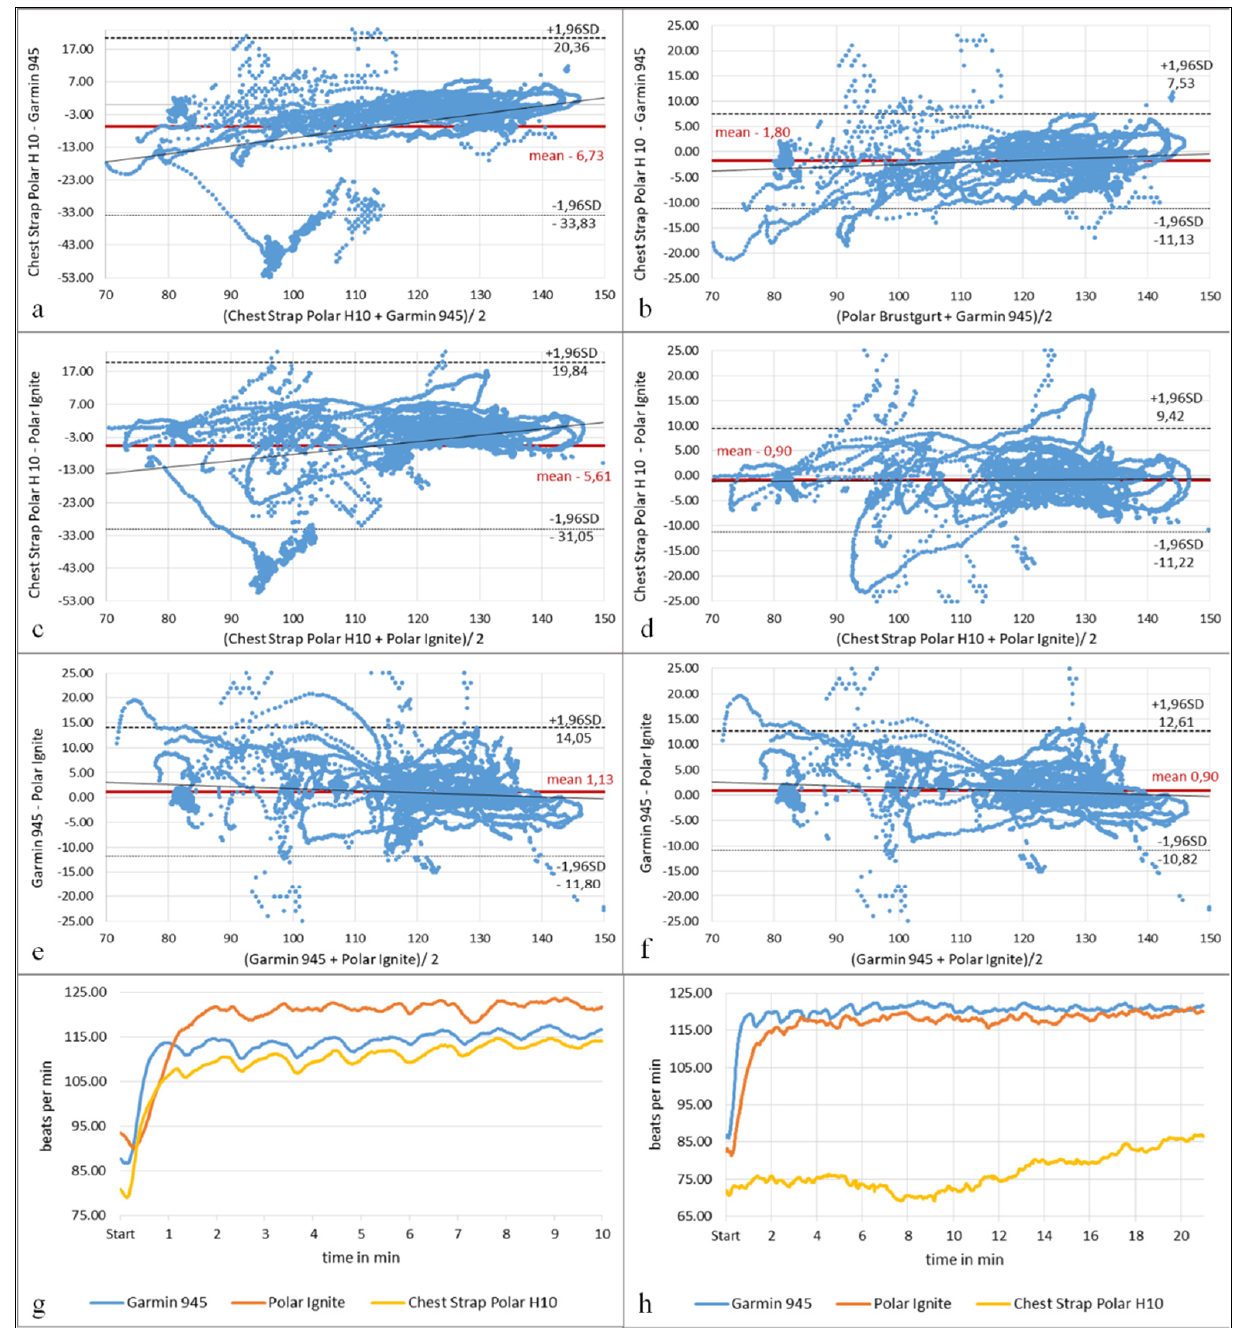
Figure 1. Bland–Altman diagrams of heart rate measurements ( n = 36). ( a ) Garmin 945 vs. criterion, ( b ) Garmin 945 vs. criterion without swim, ( c ) Polar Ignite vs. criterion, ( d ) Polar Ignite vs. criterion without swim, ( e ) Garmin 945 vs. Polar Ignite, ( f ) Garmin 945 vs. Polar Ignite without swim, ( g , h ) heart rate lines Garmin 945, Polar Ignite and chest trap Polar H10 ( g ) swim 500 m, ( h ) swim 1000 m; min = minute, mean = mean value, SD = standard deviation of the difference.